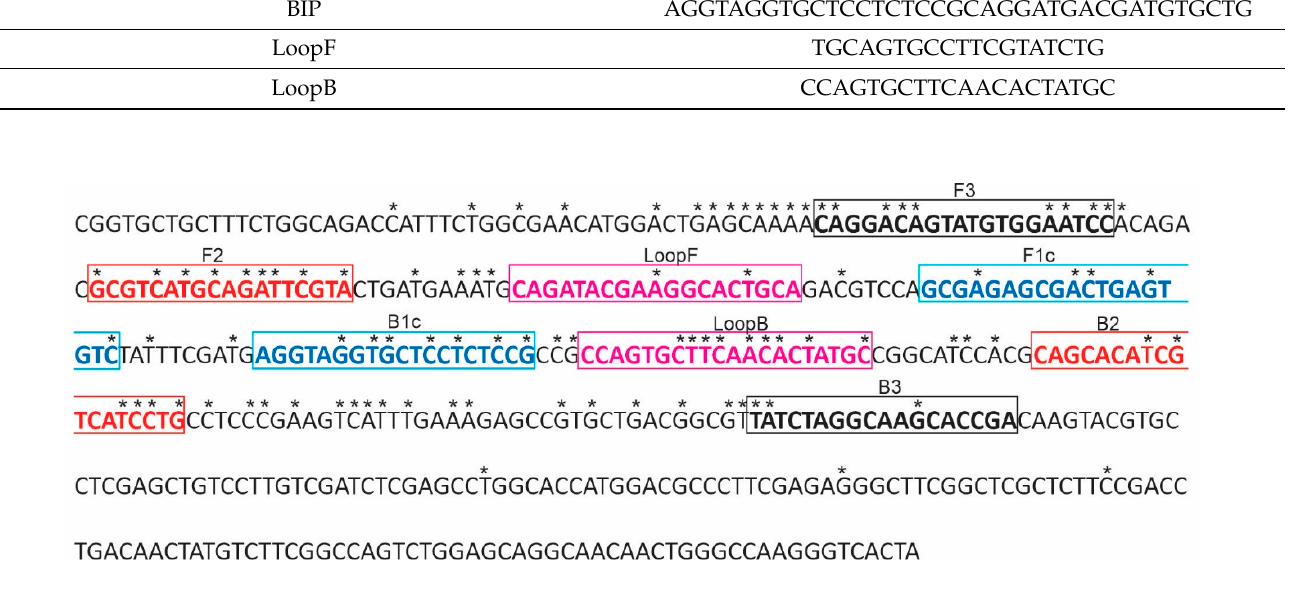
Table 1. LAMP primers specific to the β -tubulin 2 gene of Dothistroma septosporum .